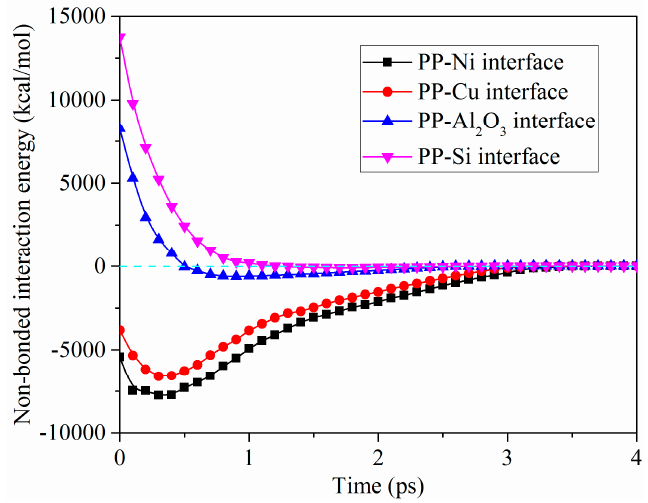
Figure 9. Non-bonded interaction energies of the four contact interfaces.